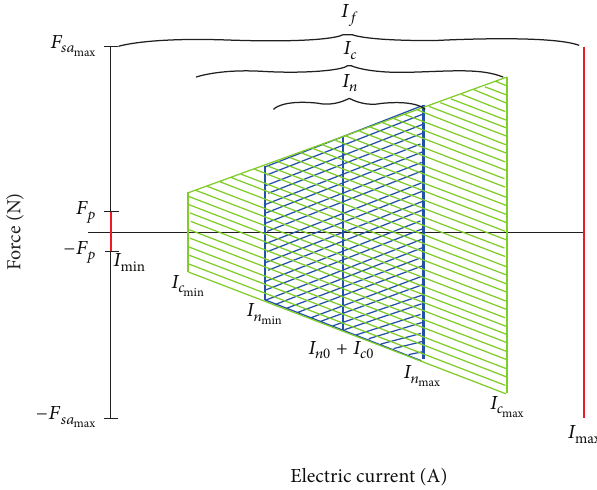
Figure 5: Force-electric current diagram in a healthy MR damper used for the adaptive